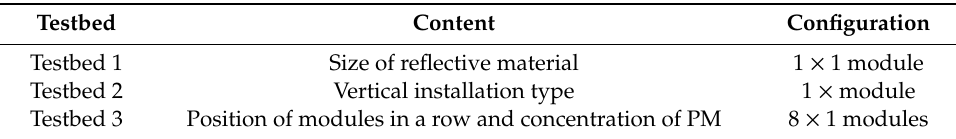
Table 4. Experiment categories.